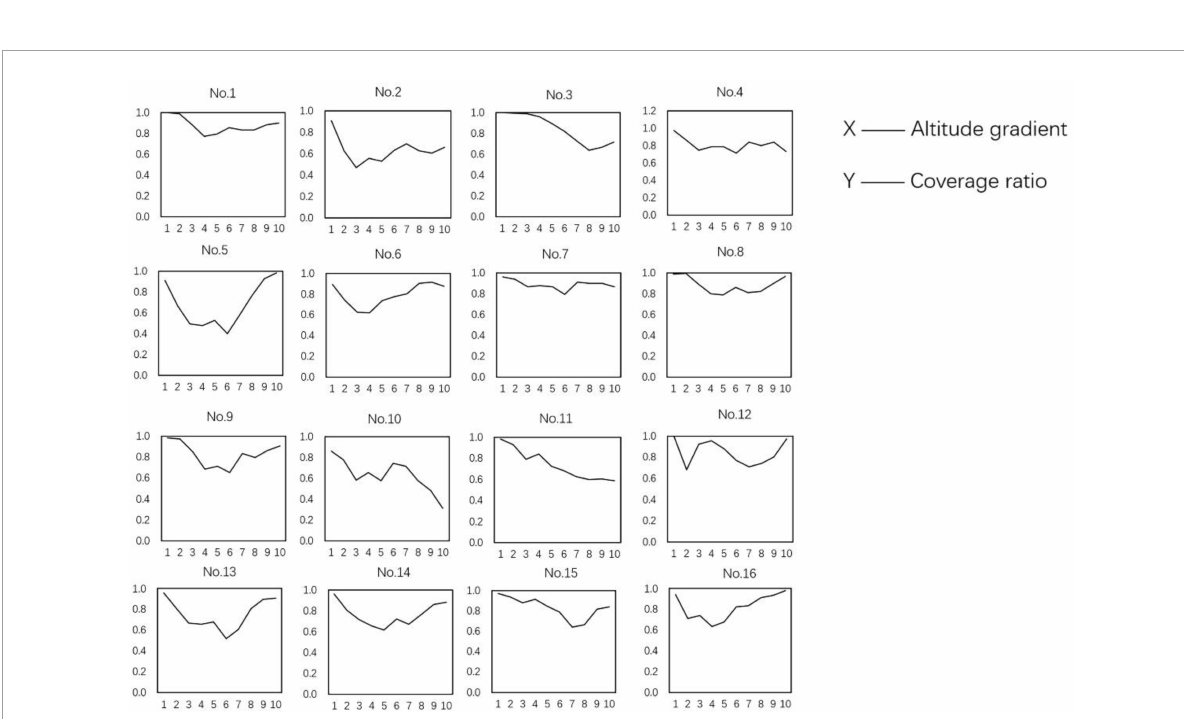
FIGURE6 Gradient change of coverage. The vertical axis represents the relative height of the cliff divided into 10 gradients with equal distances within each gradient. The point cloud is divided into two categories after segmentation statistics via formulae (1), (2), and (3): plant point cloud and cliff point cloud. The x -axis shows the altitude gradient. The y -axis shows the ratio of the plant point cloud to the total point